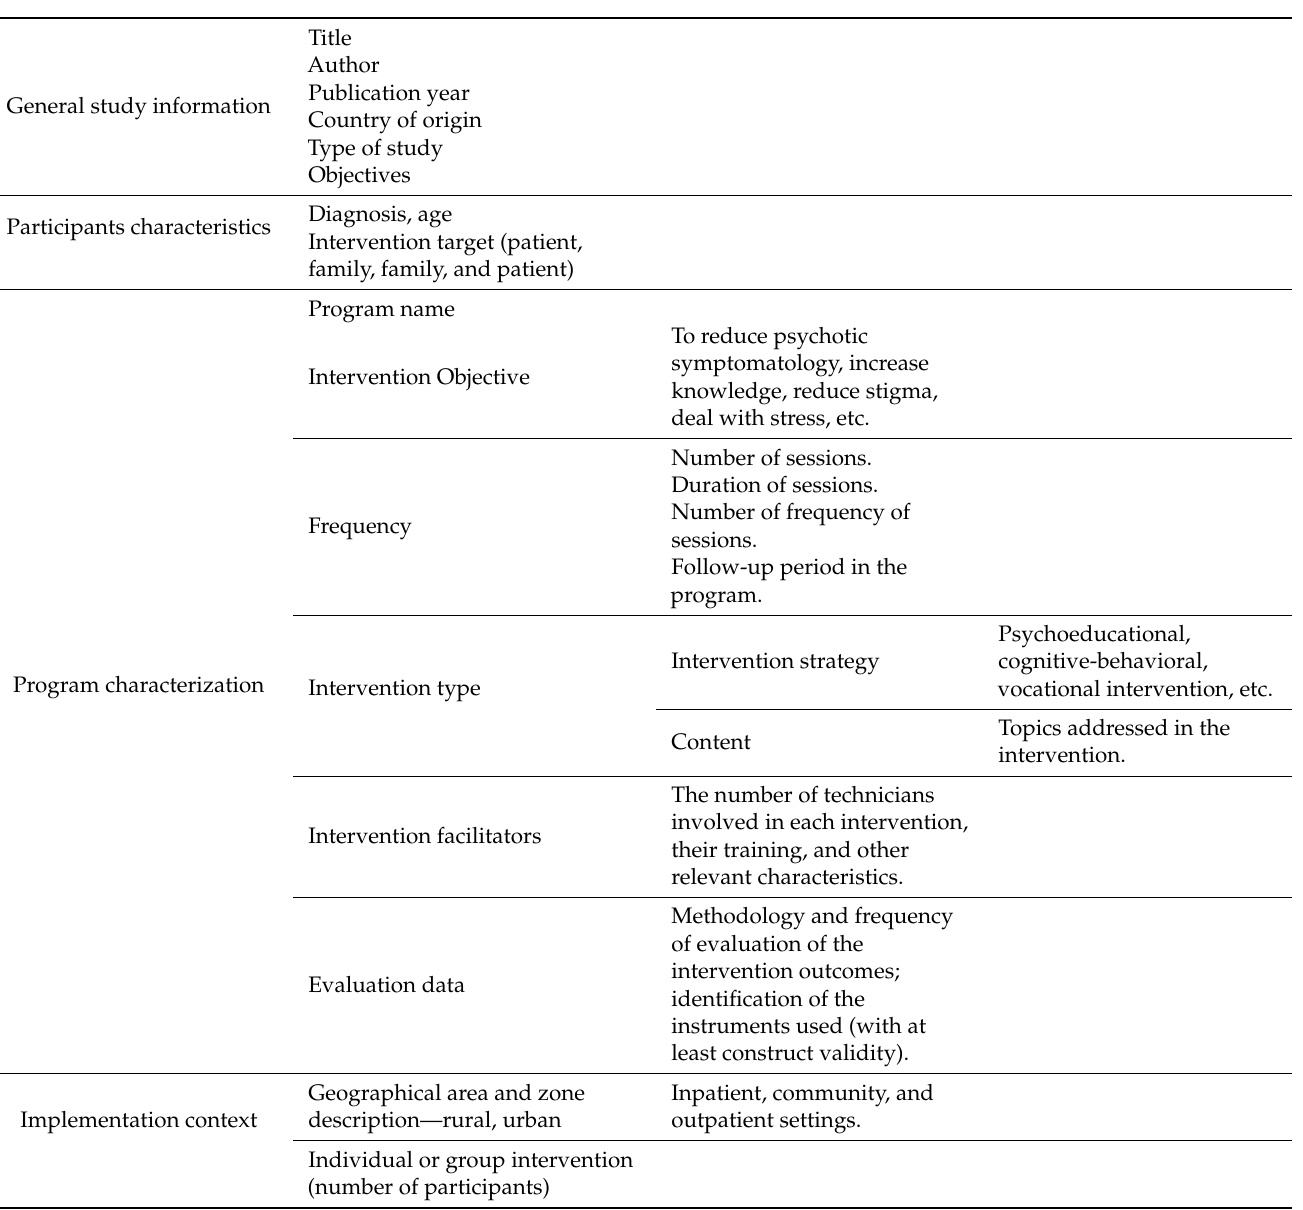
Table A2. Draft of data extraction